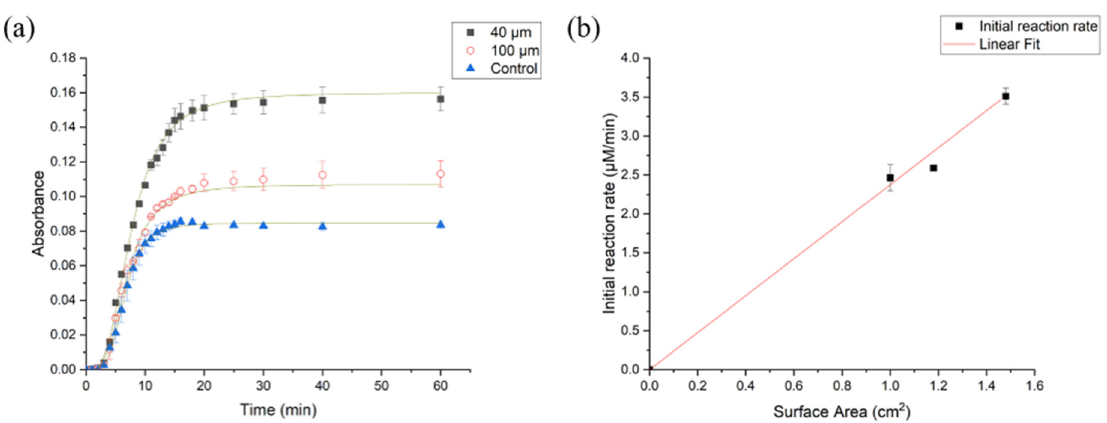
Figure 7. Kinetics of the reaction of X-Gluc grafted PUAA-ADH with ß-GUS followed at a wavelength of 615 nm, ( a ) varying the surface area of the films (using 8 mg of sample with 40 µ m cuboids, 100 µ m cuboids and a bulk non-structured film as the control); ( b ) Linearly fitted graph (forced through the origin) between initial apparent reaction rate and surface area of PUAA-ADH_X-Gluc hydrogel films. Using the calibration curve (Figure S18), the concentration of released X-Gluc was